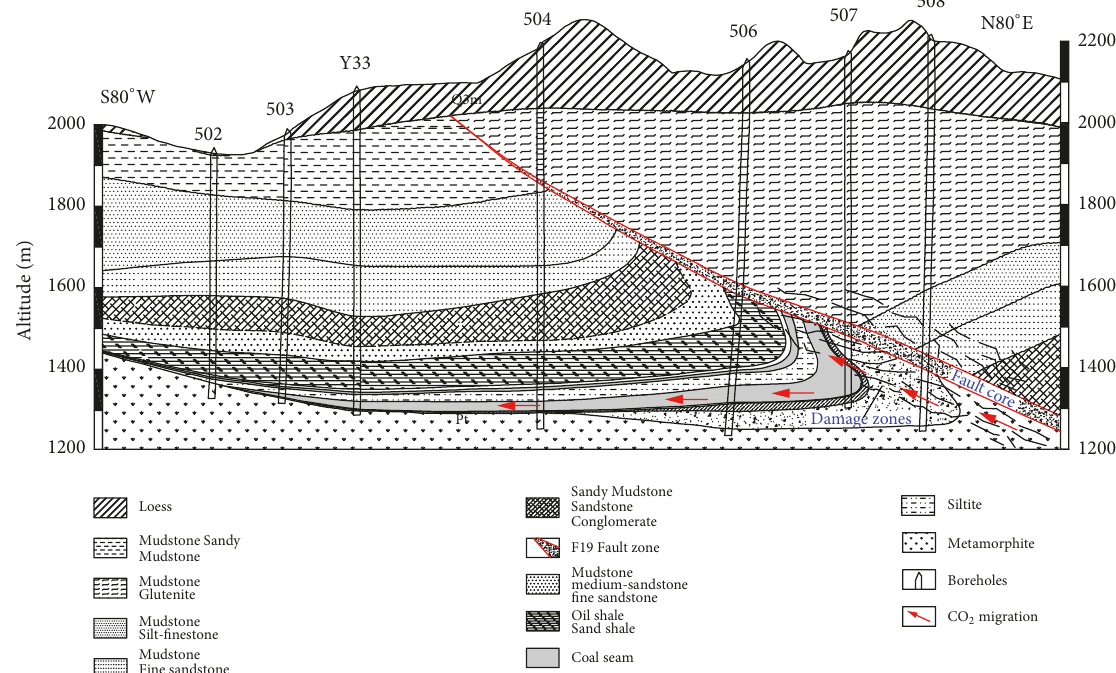
Figure 11: The mode of CO 2 enrichment and accumulation in Haishiwan